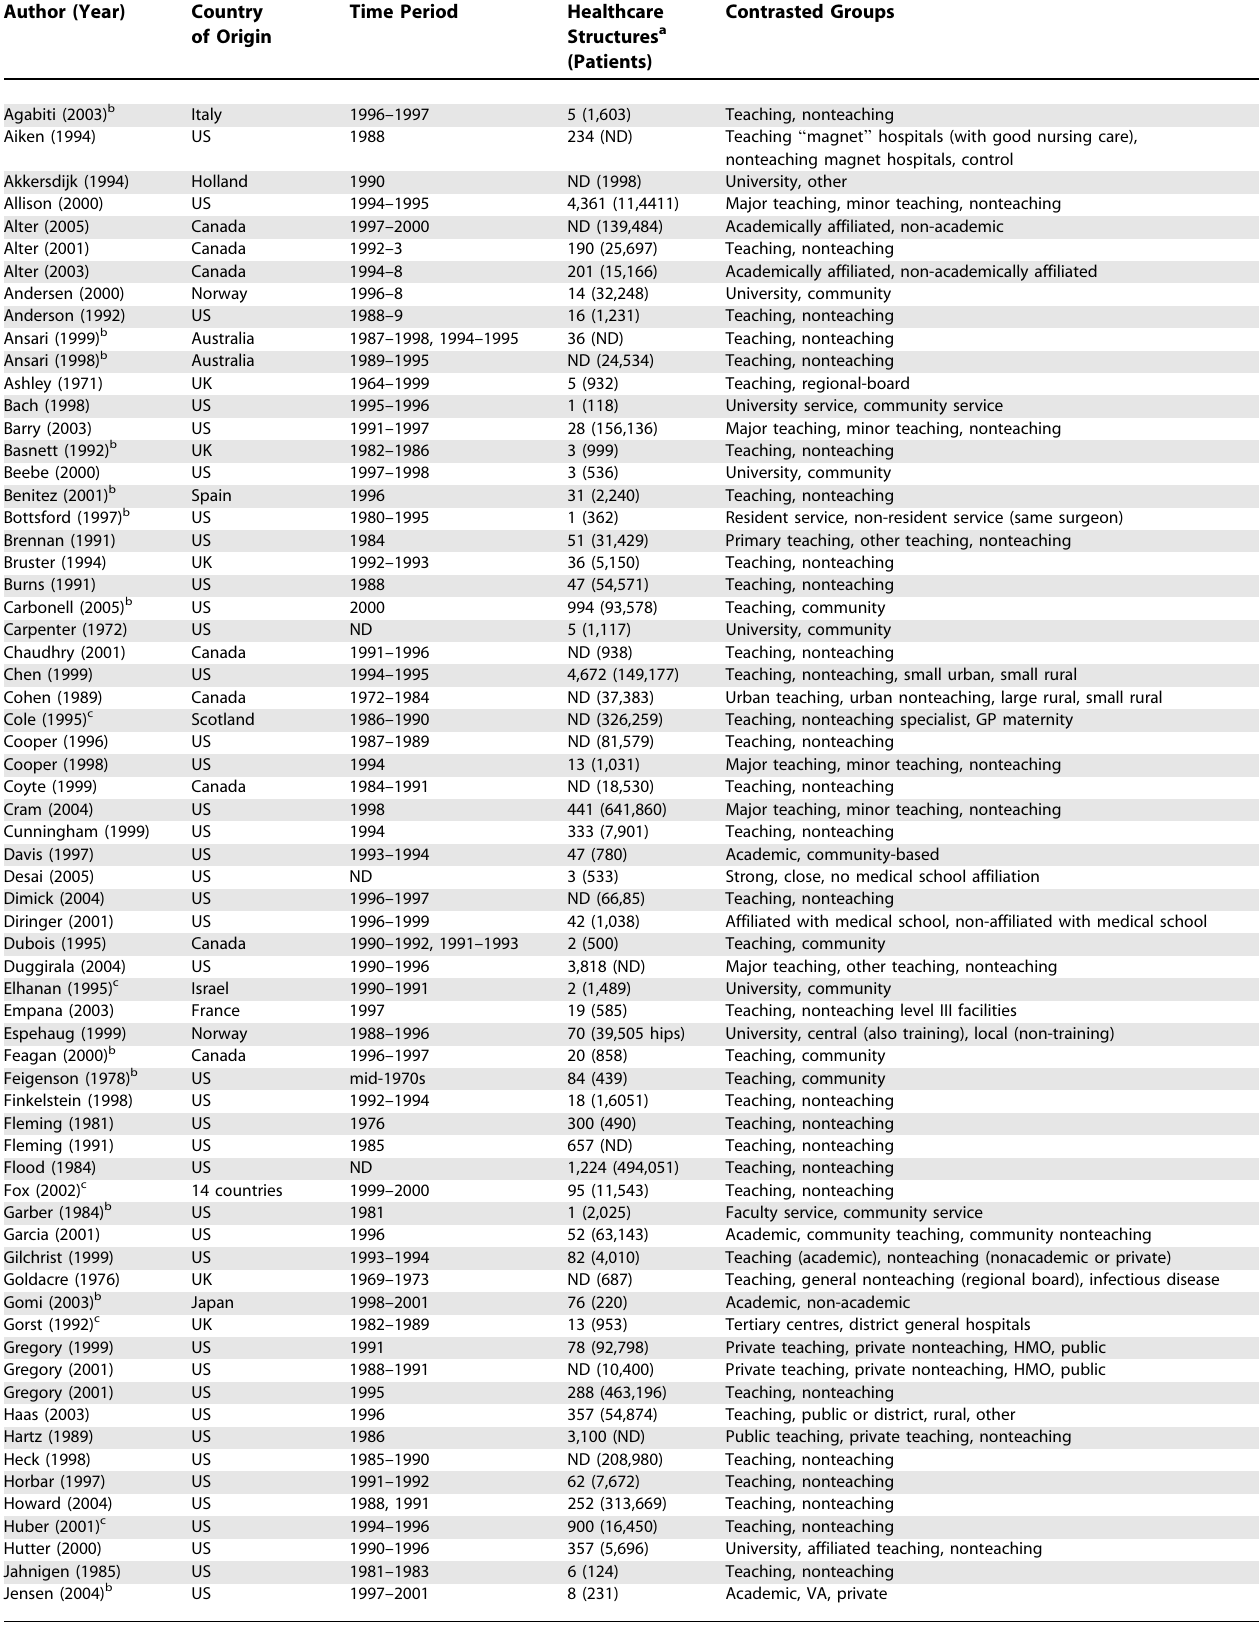
Table 1. Characteristics of Eligible